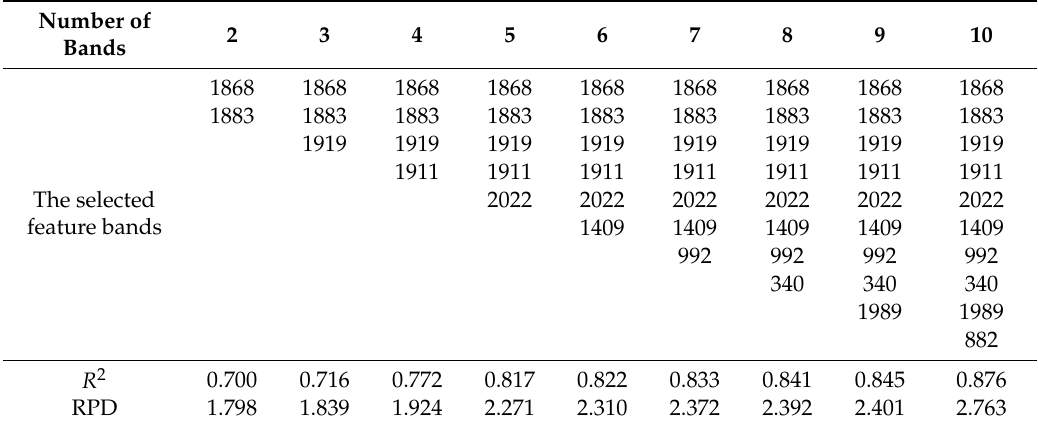
Table5. Bandsselectedbythenumberofbandsof2–10, Table 5. Bands selected by the number of bands of 2–10, selected on the basis of the FD–SPA–PLSR model.